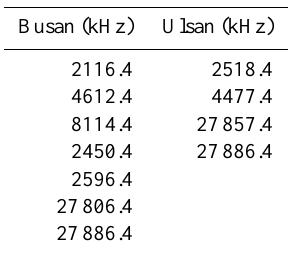
Table 5. Frequency of fishery telecommunication stations at Busan Port and Ulsan